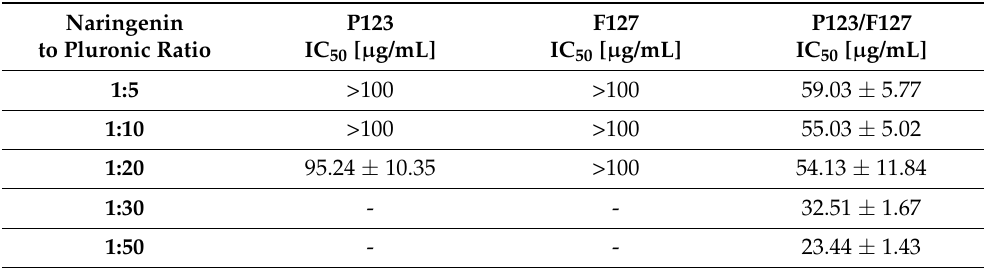
Table 6. Values of IC50 for naringenin encapsulated in polymeric micelles with different drug to Pluronic ratios. Naringenin